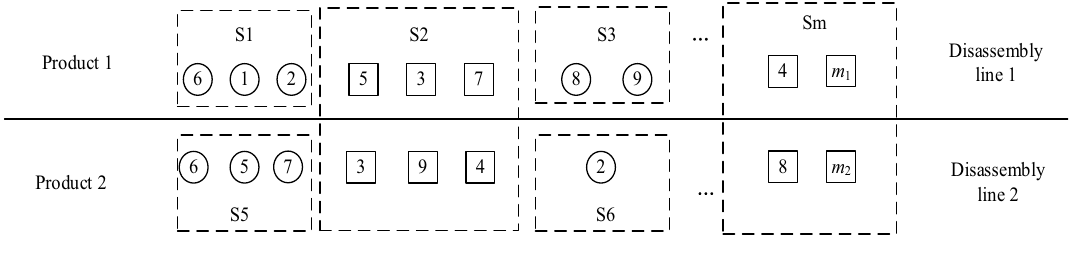
Figure 1. Parallel mixed-flow remanufacturing disassembly line layout